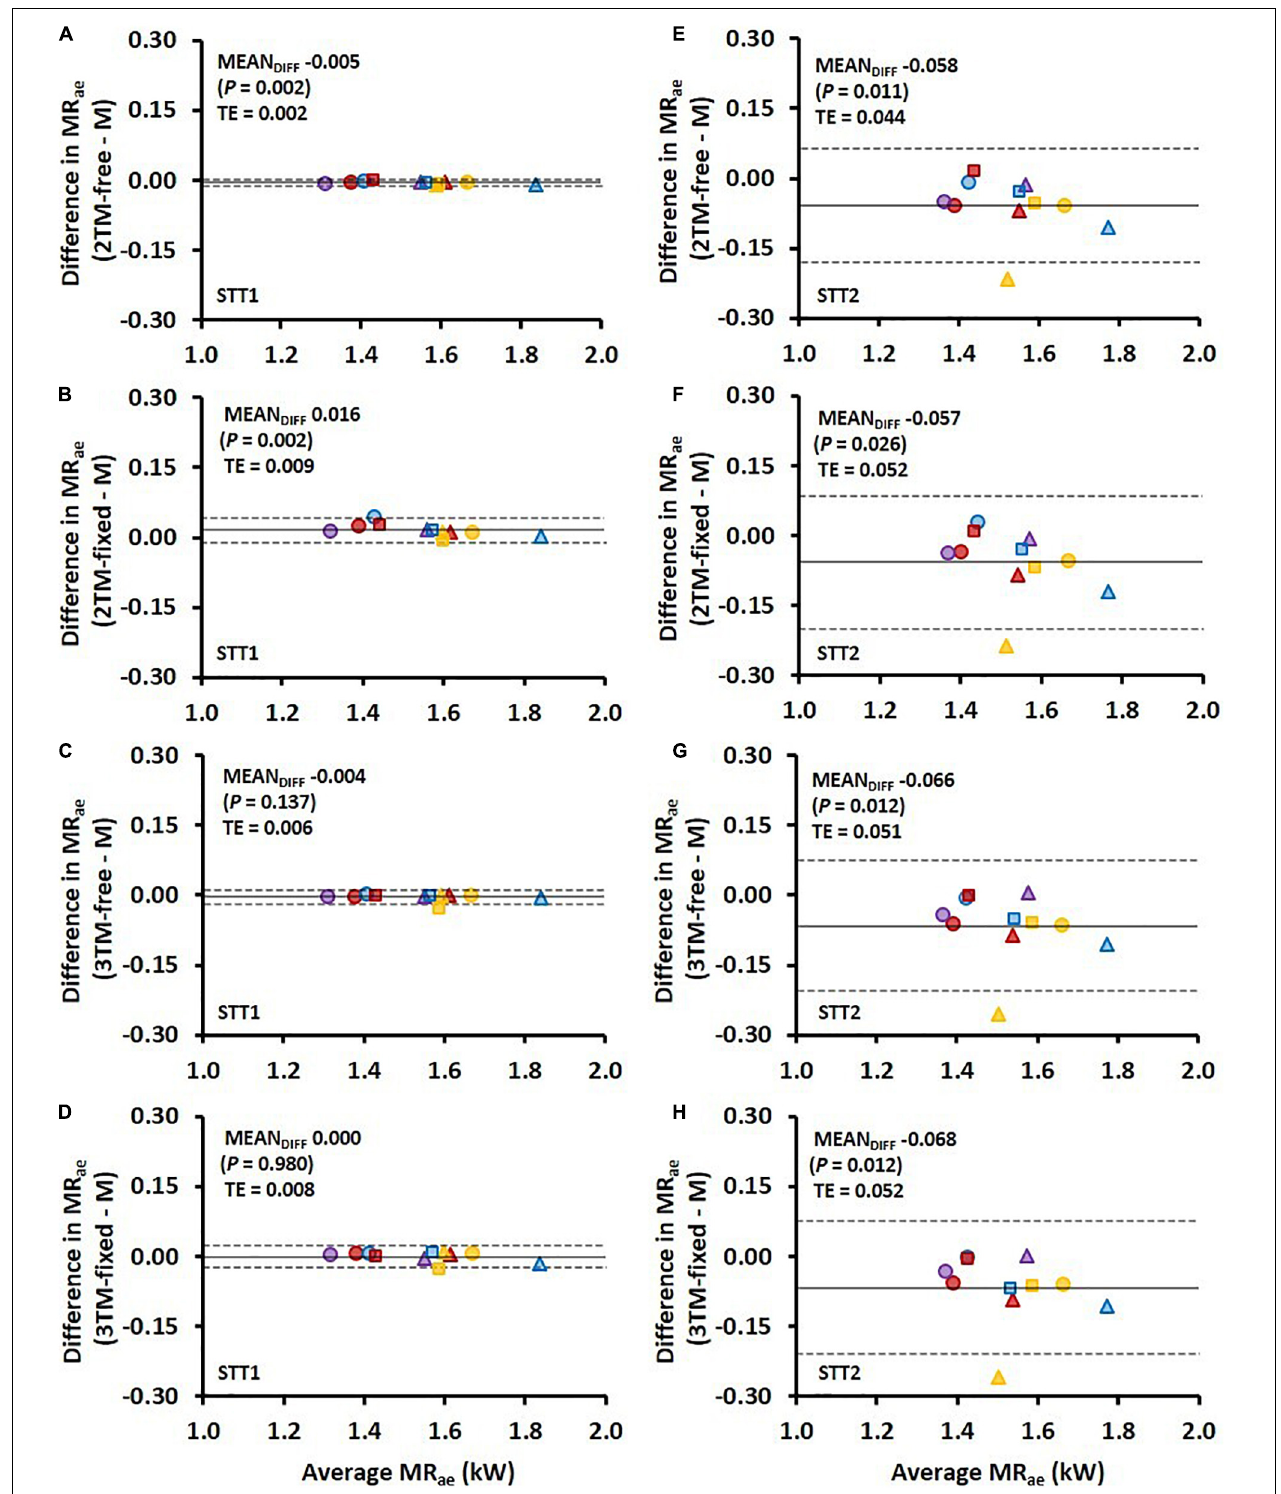
FIGURE 4 | Bland-Altman plots representing the mean difference (MEAN DIFF ) ± 95% limits of agreement (i.e., 1.96 SD) in the average aerobic metabolic rate (MR ae ) associated with the first sprint time trial (STT1) presented in (A–D) and for the second sprint time trial (STT2) presented in (E–H) for the four various bioenergetic models vs. measurement data (M). TE, typical